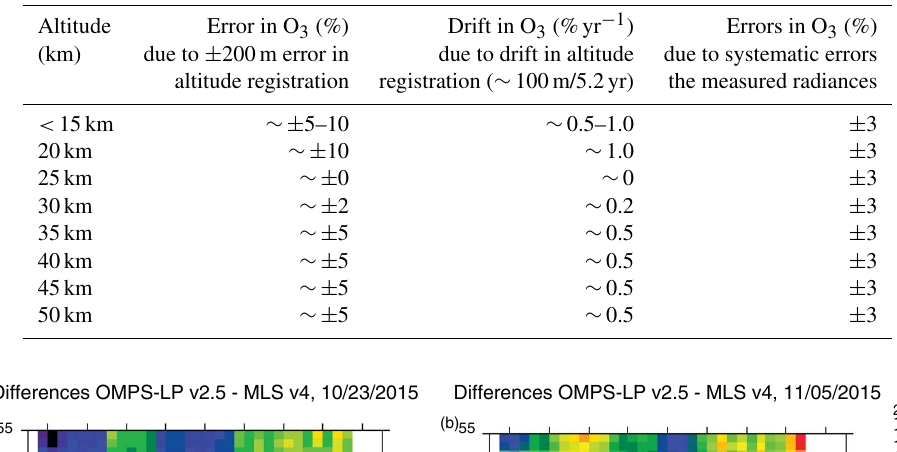
independent instruments (see Fig. 3a–b). These structures